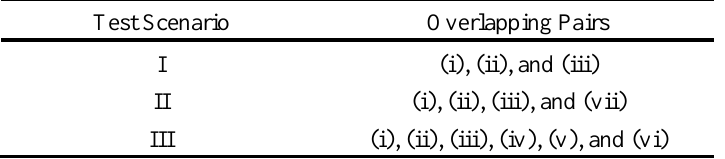
Table 2. List of the utilized overlapping pairs for the tested